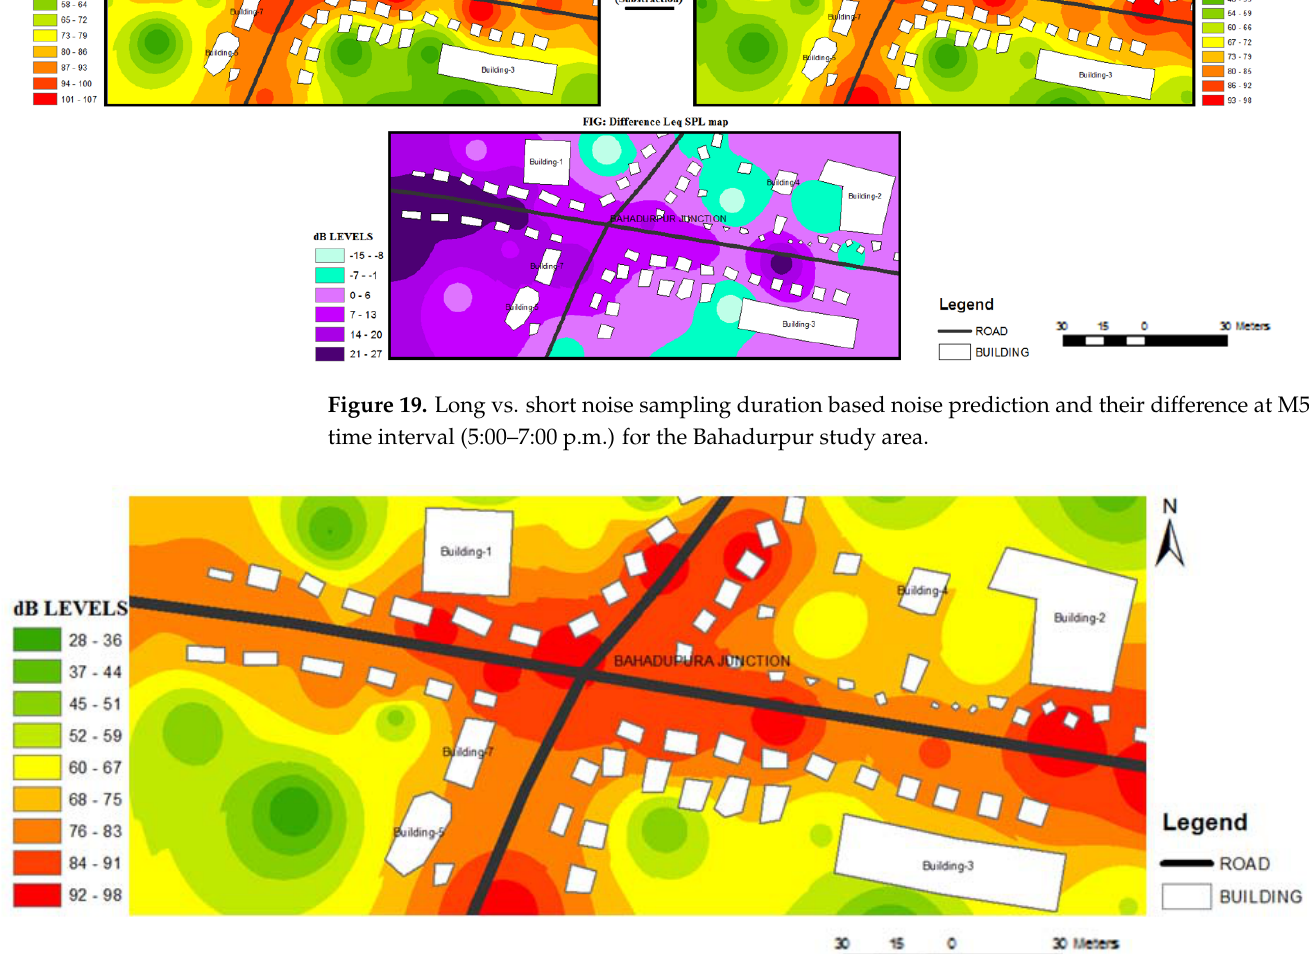
Figure 20. Predicted noise exposure level at the Bahadurpur intersection normalized for 8 h.